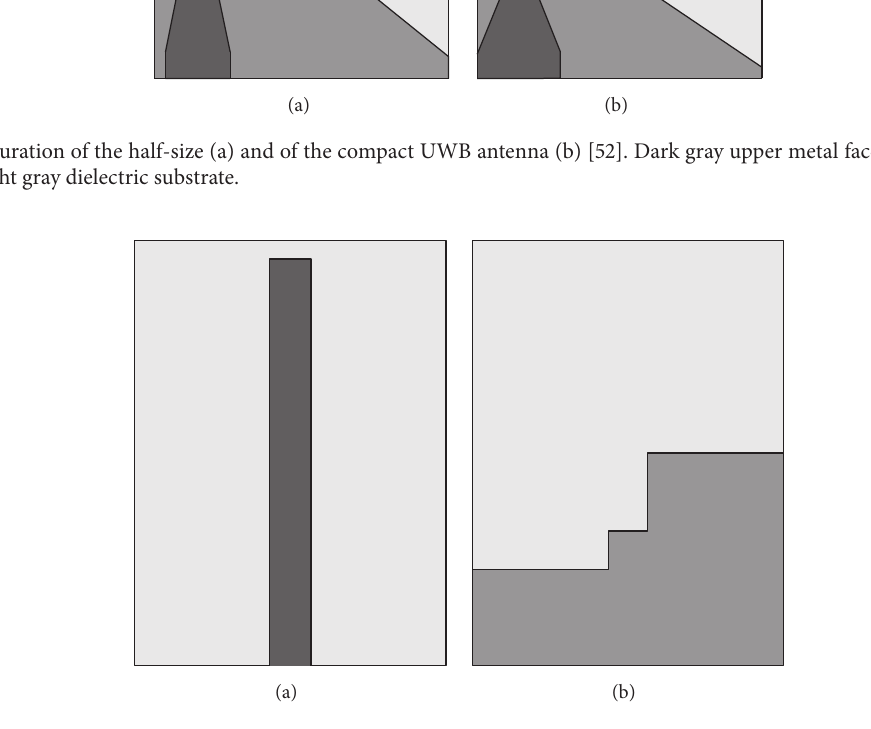
Figure 15: A planar monopole antenna with wideband circular polarization [33]. Dark gray upper metal face, medium gray bottom metal face, and light gray dielectric substrate. Top view (a) and bottom view